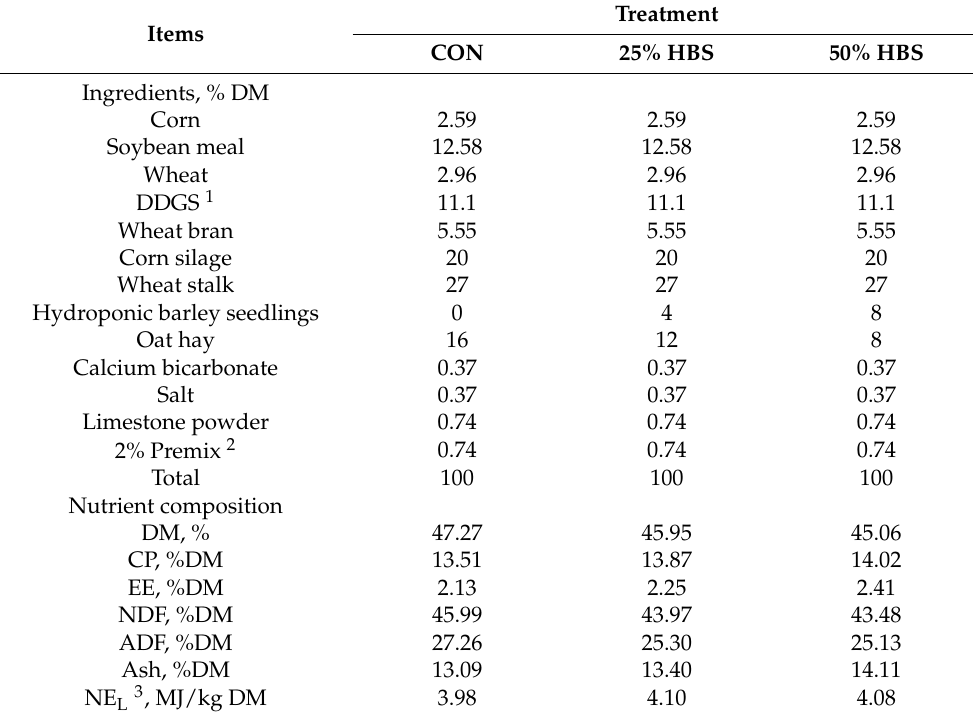
Table 1. Ingredients and nutrient compositions of the experimental diets. Treatment Items CON 25% HBS 50% HBS Ingredients, %